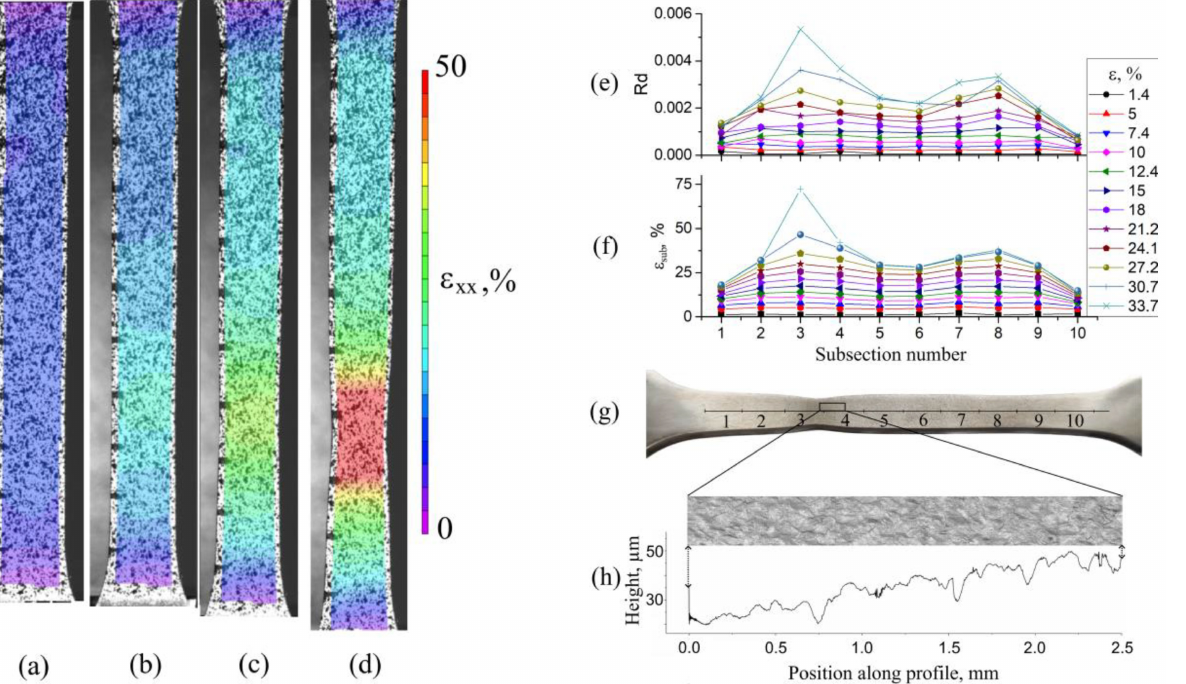
Figure 5. Strain fields ε xx obtained using DIC at tensile strains of 10% ( a ), 15% ( b ), 20% ( c ), and 25% ( d ). Dimensionless roughness parameter ( e ) and in-plane strain distributions ( f ) along the tensile axis ( g ), and the optical surface image and a roughness profile in a neck region ( h